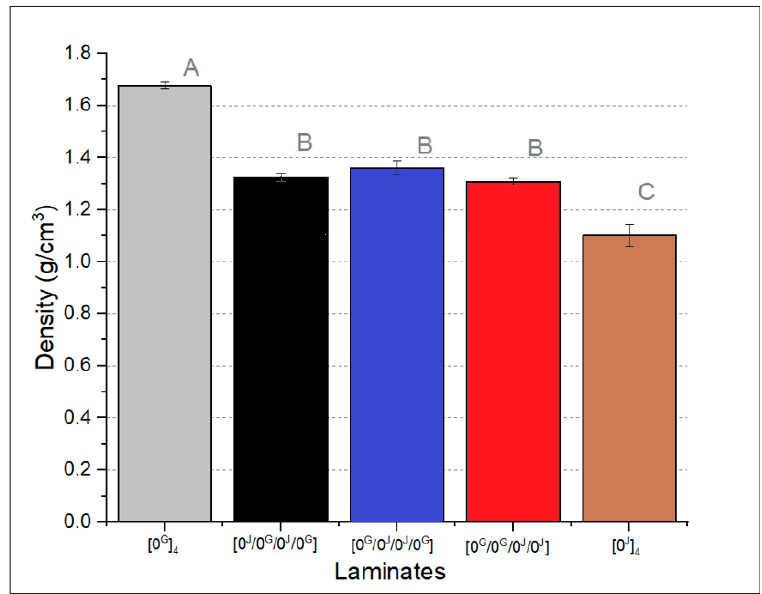
Figure 5. Measured density of the laminates (letters represent the results of the Tukey’s test).